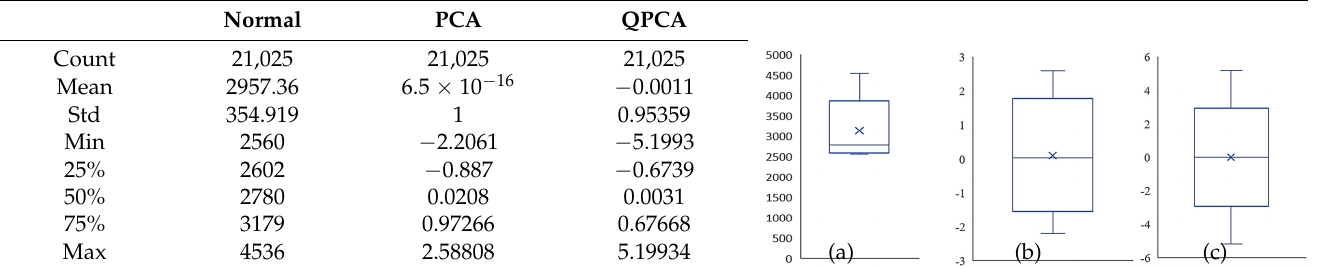
Table 3. The sample number of level-0 and level-1 datasets. It also indicates the results of the two level-0 models and the final results of the level-1 model for the IPs dataset.